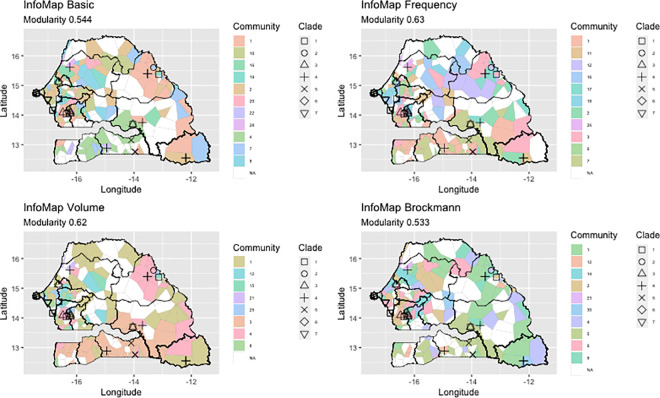
Tessellation of Senegal based on the position of mobility network nodes using the InfoMap algorithm.Each polygon, centred around nodes of the network, is coloured based on the community it has been associated with (also labelled with an id number in the legend). Only communities where at least one PPRV strain has been detected are shown in colours. Icons indicate different PPRV genetic clades based on results of the phylogenetic analyses. This figure visualizes if spatial structure is present in our network, using the community algorithm InfoMap, with different weights for the links: Basic, no weight; Frequency, the number of times the link was active; Volume, cumulative volume of animals exchanged in a year; Brockmann, using the effective Brockmann distance (see main text). The base layer for the map used in the figure was obtained at http://www.gadm.org.